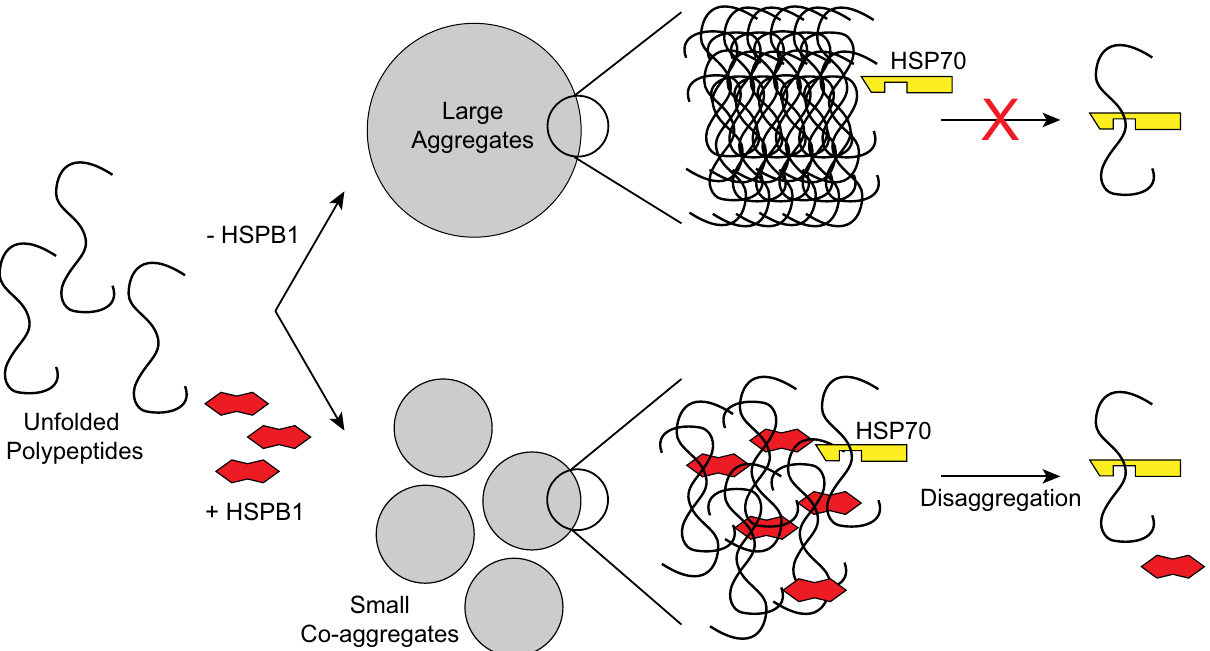
Figure 7. Model for the mechanisms of HSPB1 in aggregate solubilization. Unfolded polypeptides subjected to heat shock in the absence of HSPB1 form large amorphous aggregates that cannot be disaggregated by the HSP70 machinery. In the presence of HSPB1, polypeptides co-aggregate with the sHSP generating small globular aggregates. Under these conditions, the HSP70 disaggregation machinery, formed by HSP70